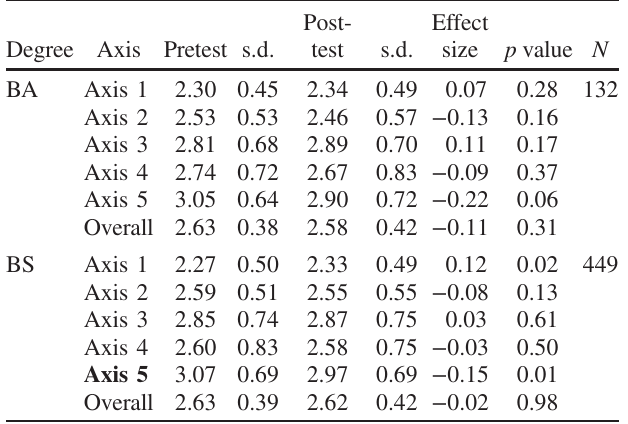
Degree Axis Pretest s.d.